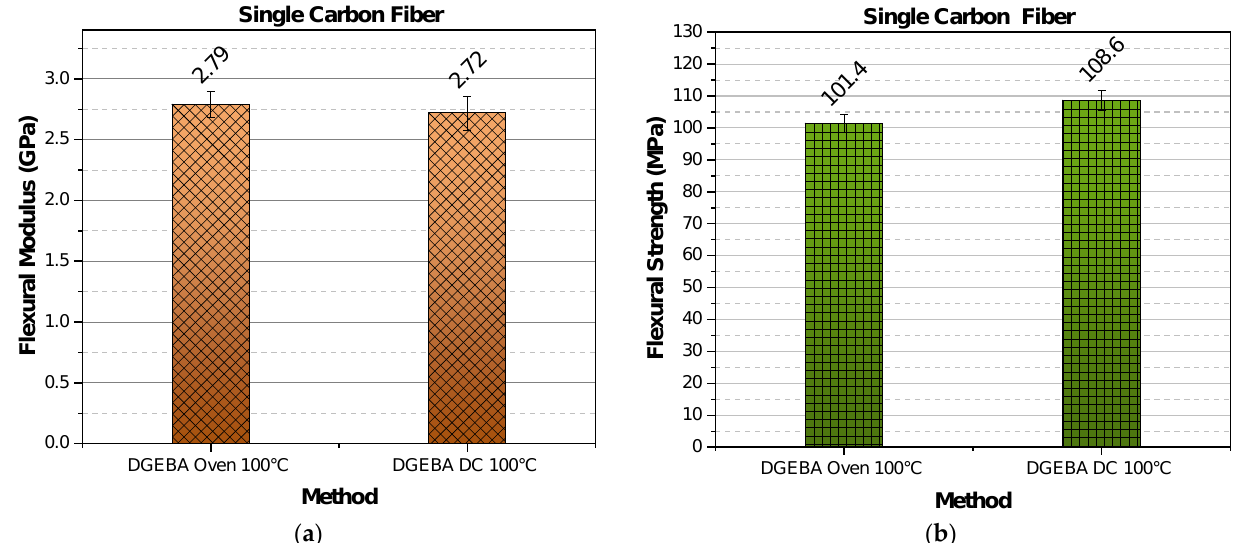
Figure 9. ( a ) Flexural modulus and ( b ) Flexural strength versus curing method for single carbon fiber specimens.